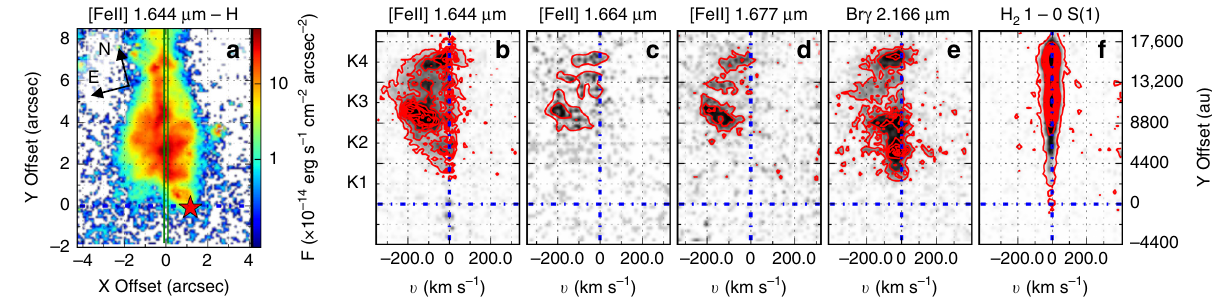
Fig. 2 Position – velocity diagram of the G35.2 – 0.74N protostellar jet. a HST [Fe II] − H image oriented in the slit position (green lines, PA = − 14.7°), north and east are recorded in the top-left corner of the fi gure, the central source is indicated with a red star, and the fl ux values are indicated in the colour bar to the right. b ISAAC spectral image of the [Fe II] line at 1.644 μ m. c ISAAC spectral image of the [Fe II] line at 1.664 μ m. d ISAAC spectral image of the [Fe II] lin e at 1.677 μ m. e ISAAC spectral image of the Br γ line at 2.166 μ m. f ISAAC spectral image of the H 2 line at 2.121 μ m (1 − 0 S(1)). The red contours represent the intensity in the spectral images and are from 3 σ to 40 σ in steps of 3 σ . The horizontal blue dashed lines indicate the position 0 ″ in the Y Offset while the vertical blue dashed lines indicate the position of 0 km − 1 in panels ( b –